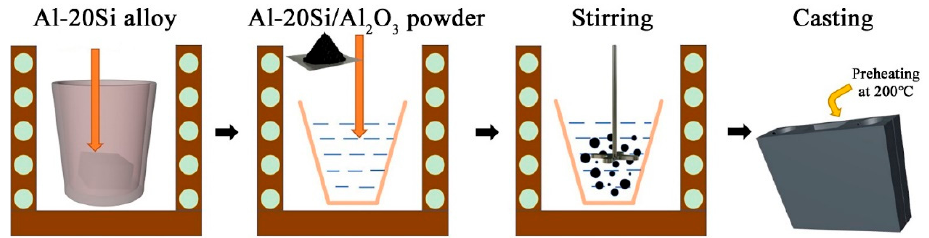
Figure 2. Preparation of Al–20Si alloy modified with Al–20Si@Al 2 O 3 powder.